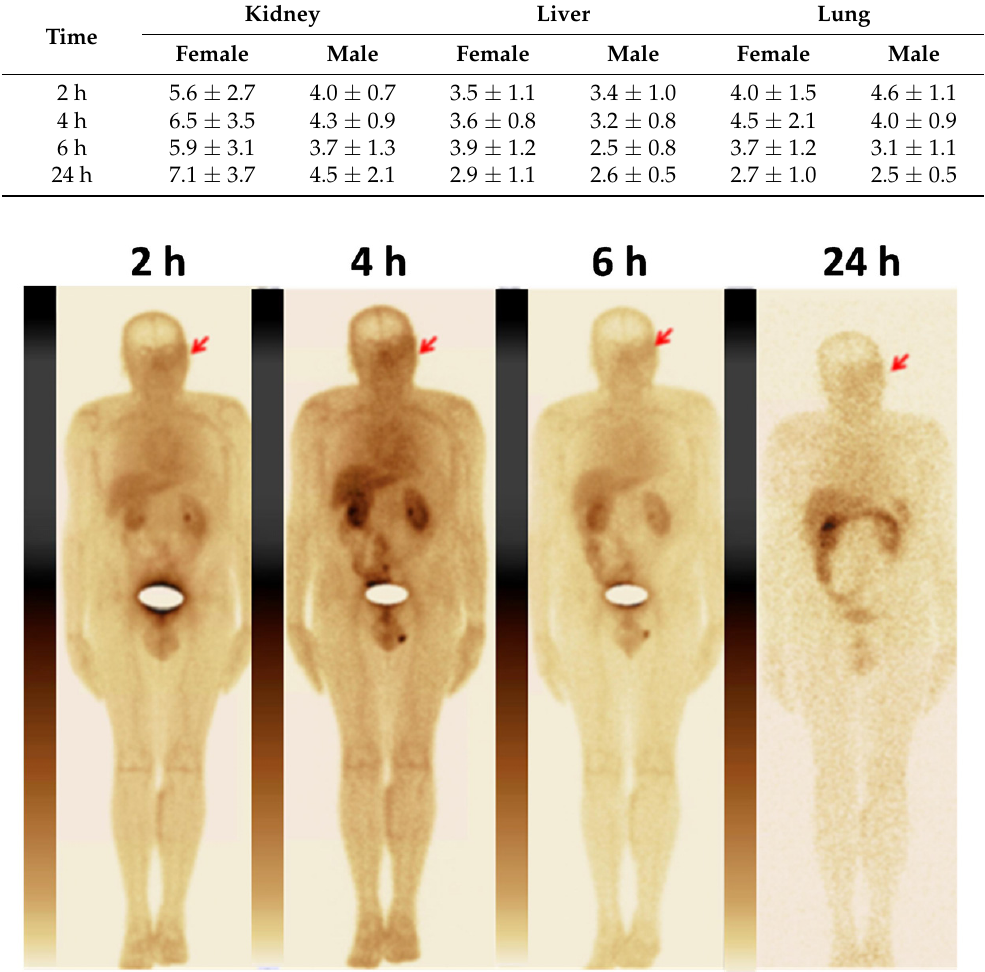
Table 2. Decay-corrected uptake of 99m Tc in the highest-uptake organs based on planar imaging of tumor-free areas. The data are presented as average %ID ± SD per organ for six females and four males at different time points after injection with [ 99m Tc]Tc-TG. Kidney Liver Lung Time Female Male Female Male Female